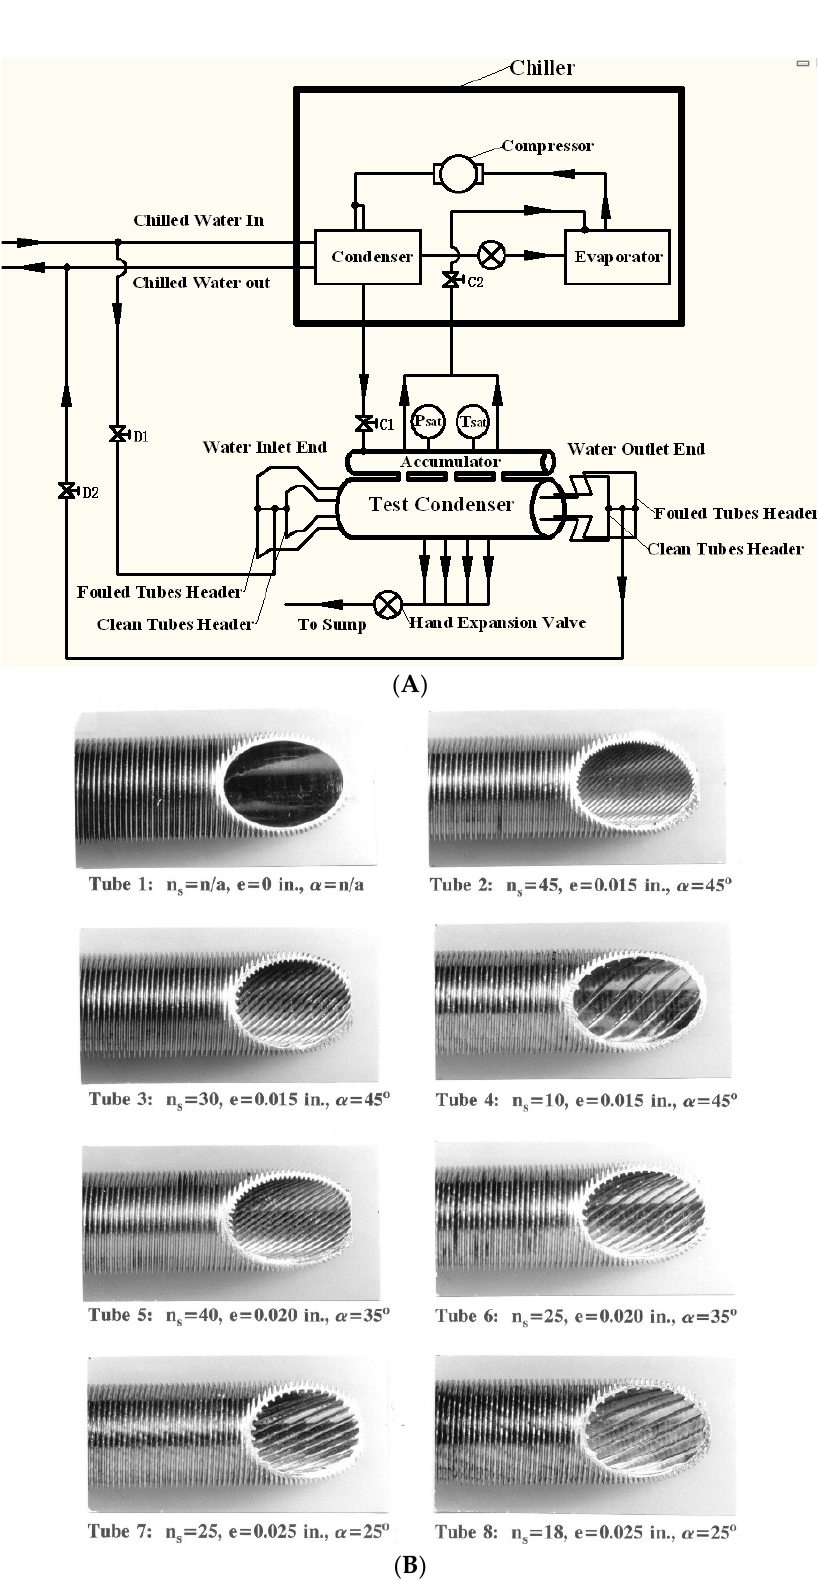
Figure 10. Systematic diagram of test apparatus of fouling tests in a condenser in a cooling tower system [15]: ( A ) test apparatus, ( B ) test tubes.